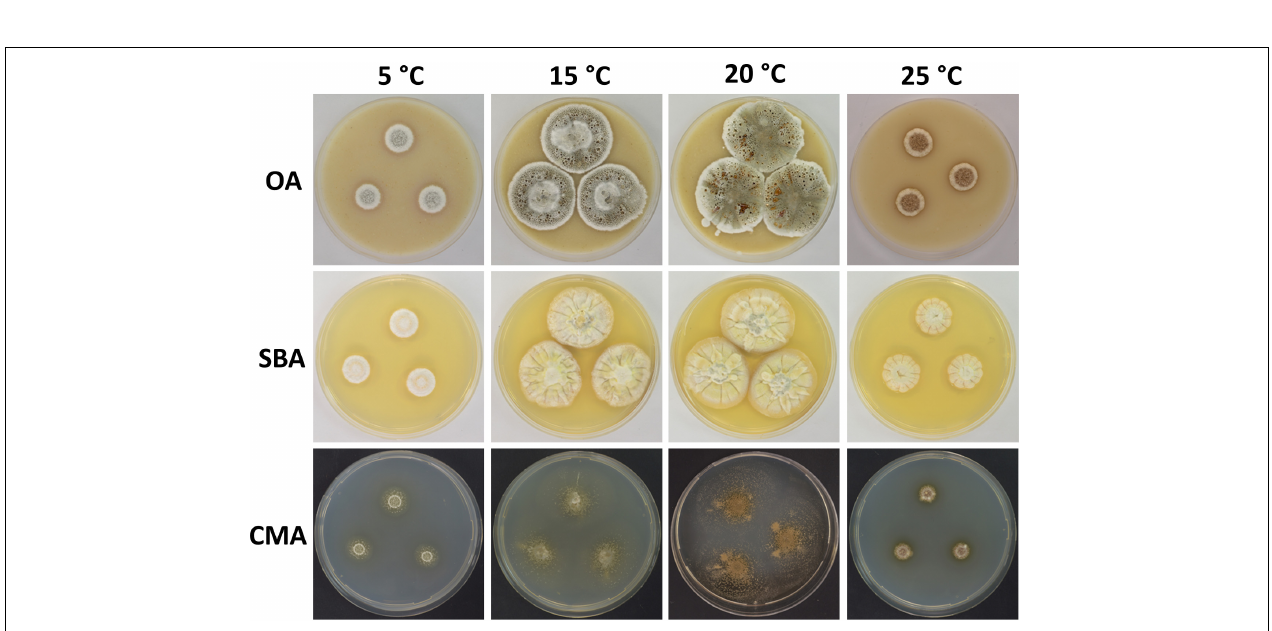
FIGURE 6 | Colony morphology of Pseudogymnoascus griseus sp. nov. grown on OA, SBA, and CMA media at 5, 15, 20, and 25 ◦ C after 28 days of incubation.